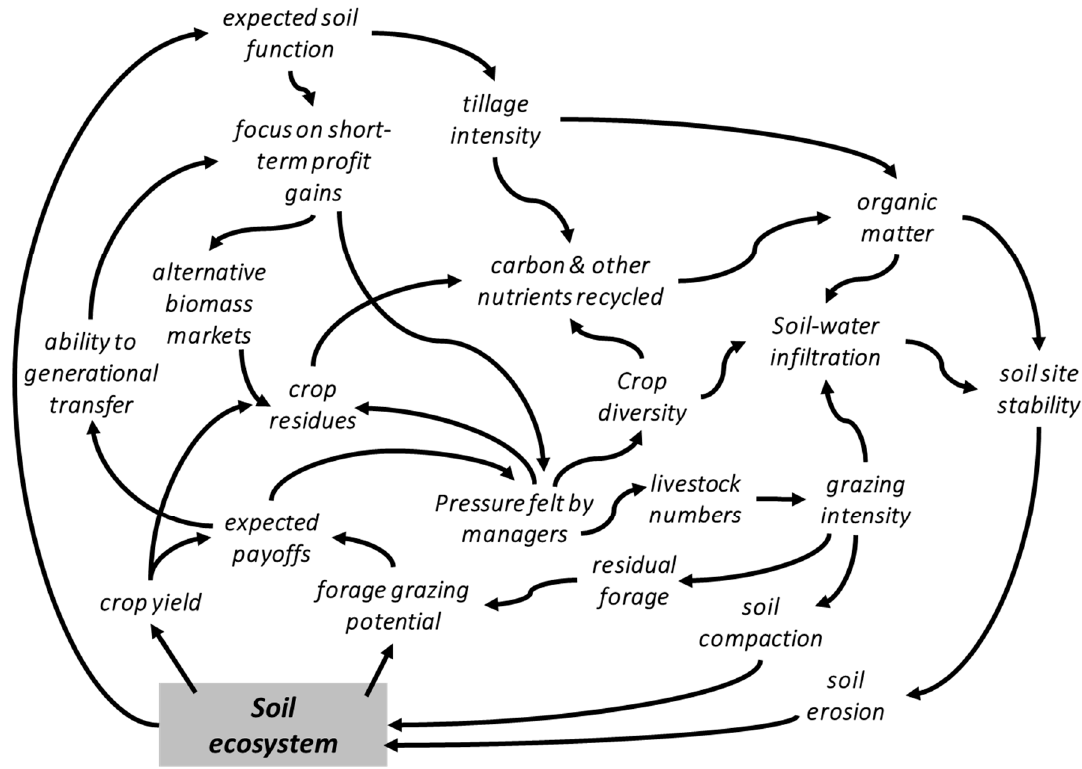
Figure 4. Schematic representation capturing some (but not all) key soil-managerial feedbacks at the agroecosystem field level. Black arrows represent causal feedback links where the variable at the arrow tail directly impacts the variable at the arrow head. For example, soil ecosystem function directly drives crop yield and forage grazing potential, both of which have profit (payoff) implications for the managers. As payoffs change, the manager feels pressure to adjust management, such as altering cropping system features such as crop diversity or adding or removing livestock. Such decisions have cascading effects back on soil ecosystem function via changes in soil cover (residual forage or crop residues), nutrient and water cycling, and physical stability (erosion or compaction).